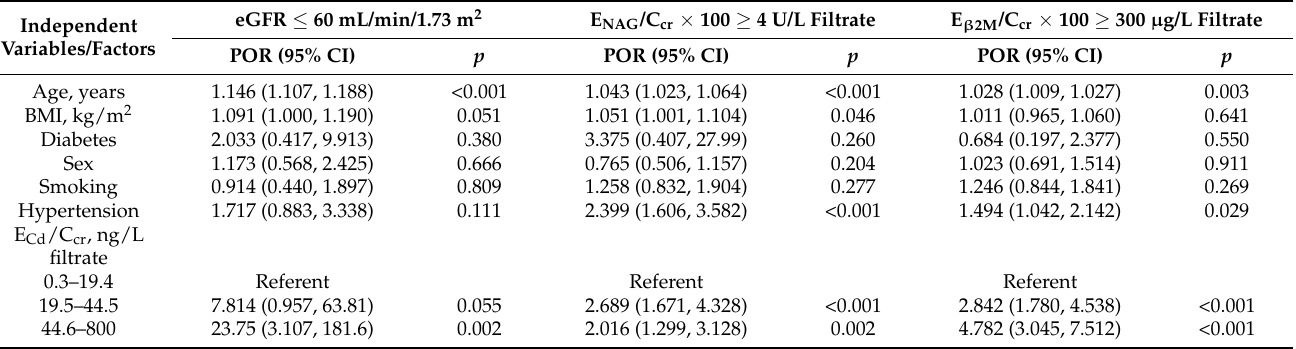
Table 6. Dose–response analysis of E Cd /C cr and the risk of adverse effects on the